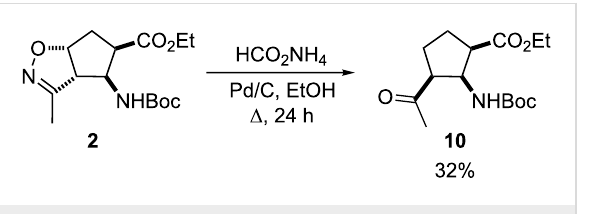
Scheme 3: Reduction with Pd/C in the presence of HCO 2 NH 4 .